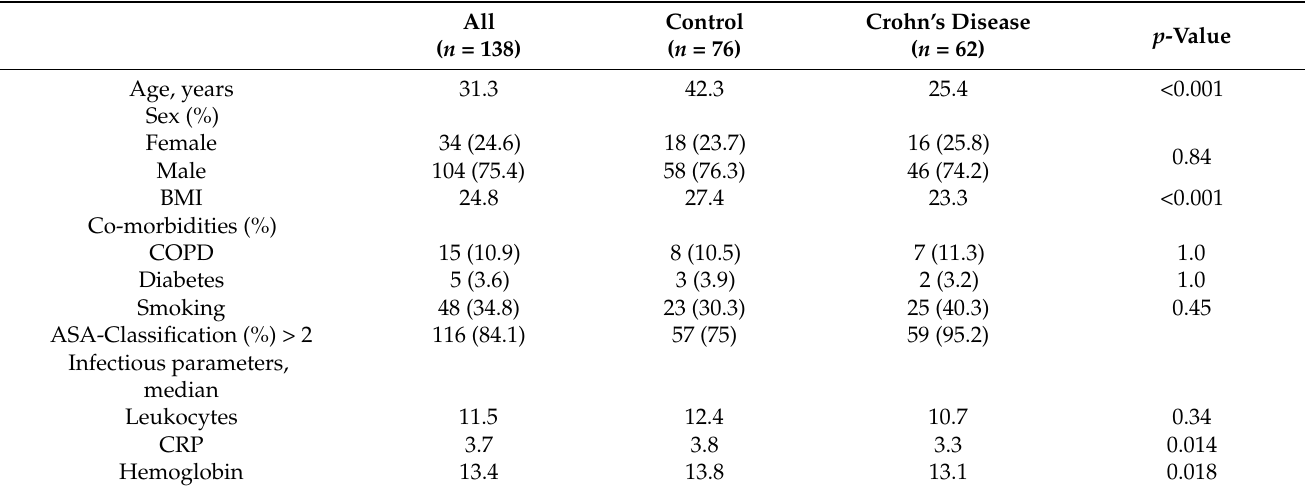
Table 1. Patient characteristics. BMI body mass index, CVRF cardiovascular risk factors, COPD chronic obstructive pulmonary disease, ASA American Society of Anesthesiologists, Hb hemoglobin, CRP C-reactive protein.